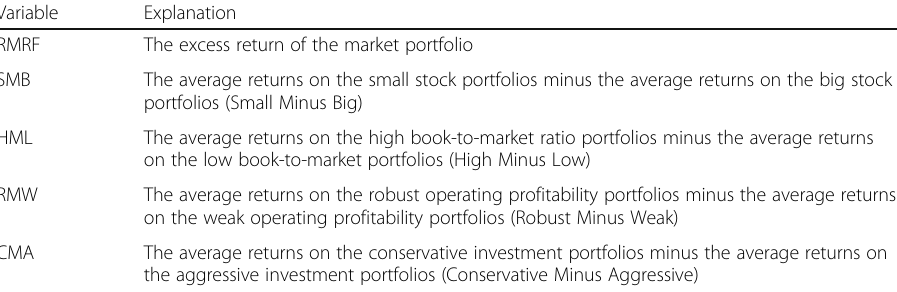
Table 2 List of Fama-French factors